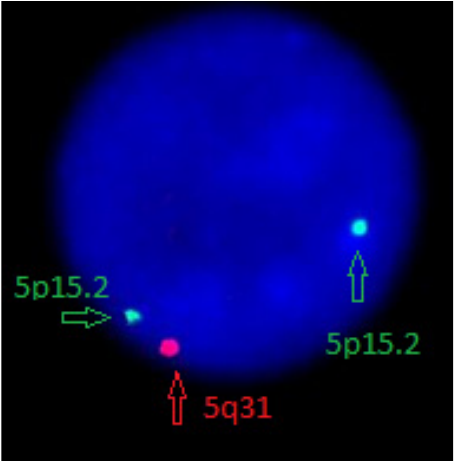
Figure 1. FISH probe: LSI EGR1/D5S23, D5S721 Dual Color Probe Kit (CE). Abnormal cell containing the deletion: the one orange and two green (1O2G) signal pattern is observed.